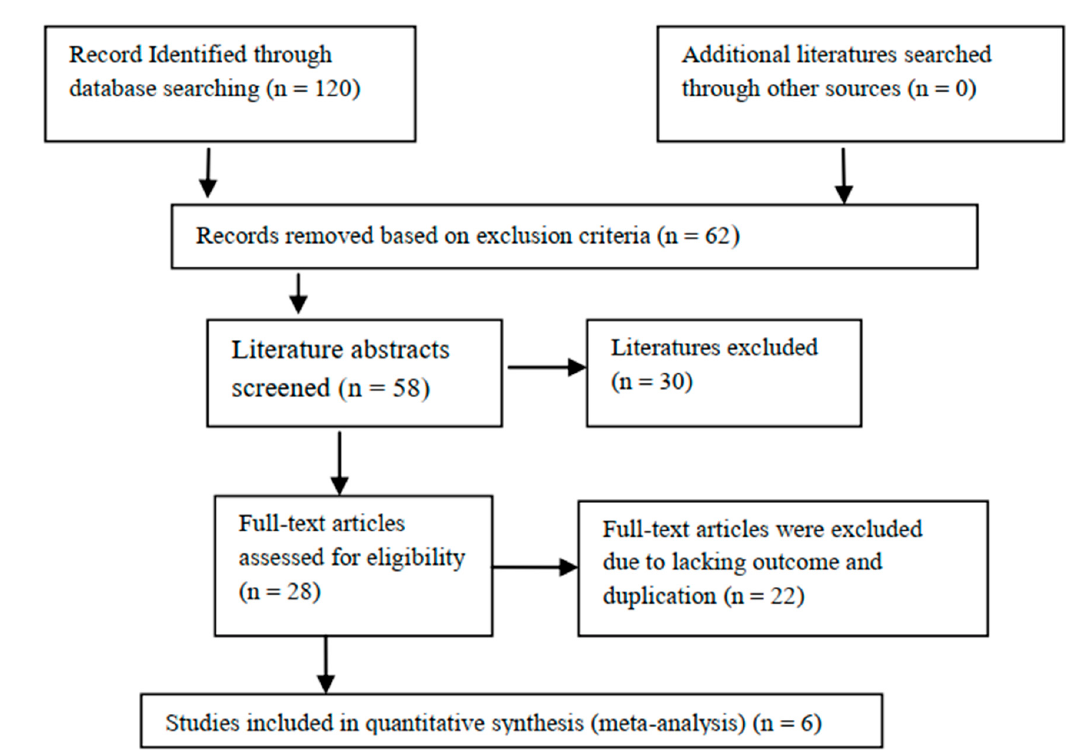
Figure 1. Flow chart of studies included and excluded. Table 1. Characteristics of the included studies.